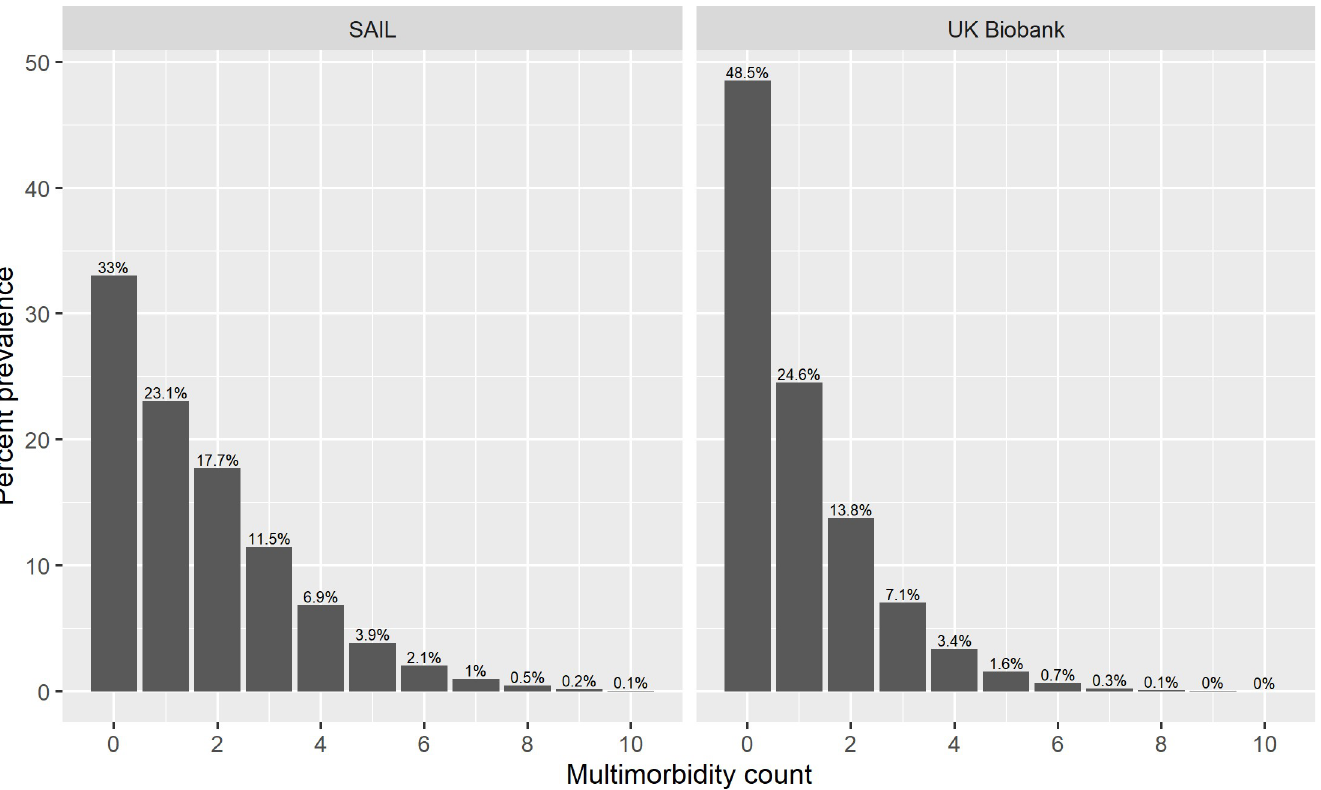
Fig 1. Distribution of counts in UK Biobank and SAIL. Bar plot showing the percentage of participants at baseline with each LTC count for UK Biobank and SAIL, respectively. LTC, long-term condition; SAIL, Secure Anonymised Information Linkage.